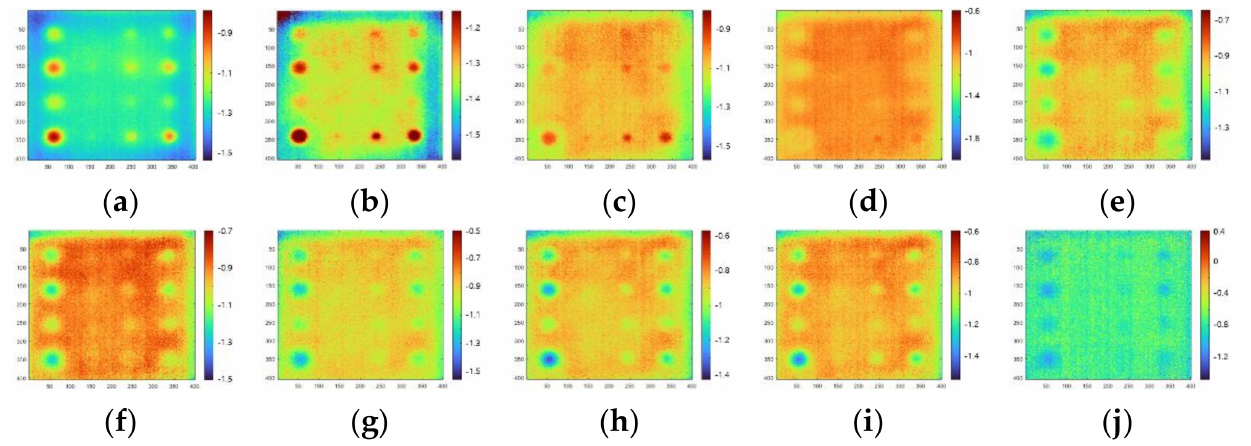
Figure 6. Phase images from the lock-in signal processing: ( a ) 0.01 Hz, ( b ) 0.02 Hz, ( c ) 0.03 Hz, ( d ) 0.04 Hz, ( e ) 0.05 Hz, ( f ) 0.06 Hz, ( g ) 0.07 Hz, ( h ) 0.08 Hz, ( i ) 0.09 Hz and ( j ) 0.1